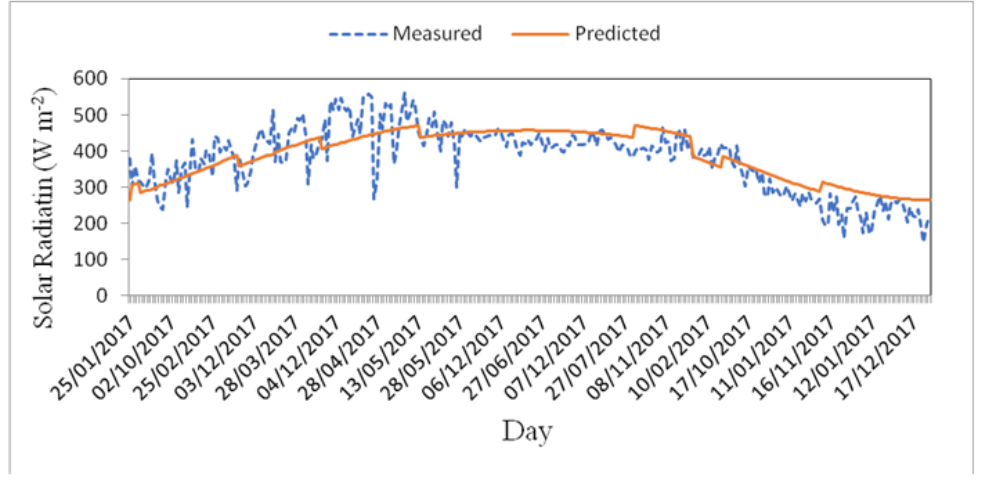
Figure 16. Predicted and measured solar radiation from solar collector.